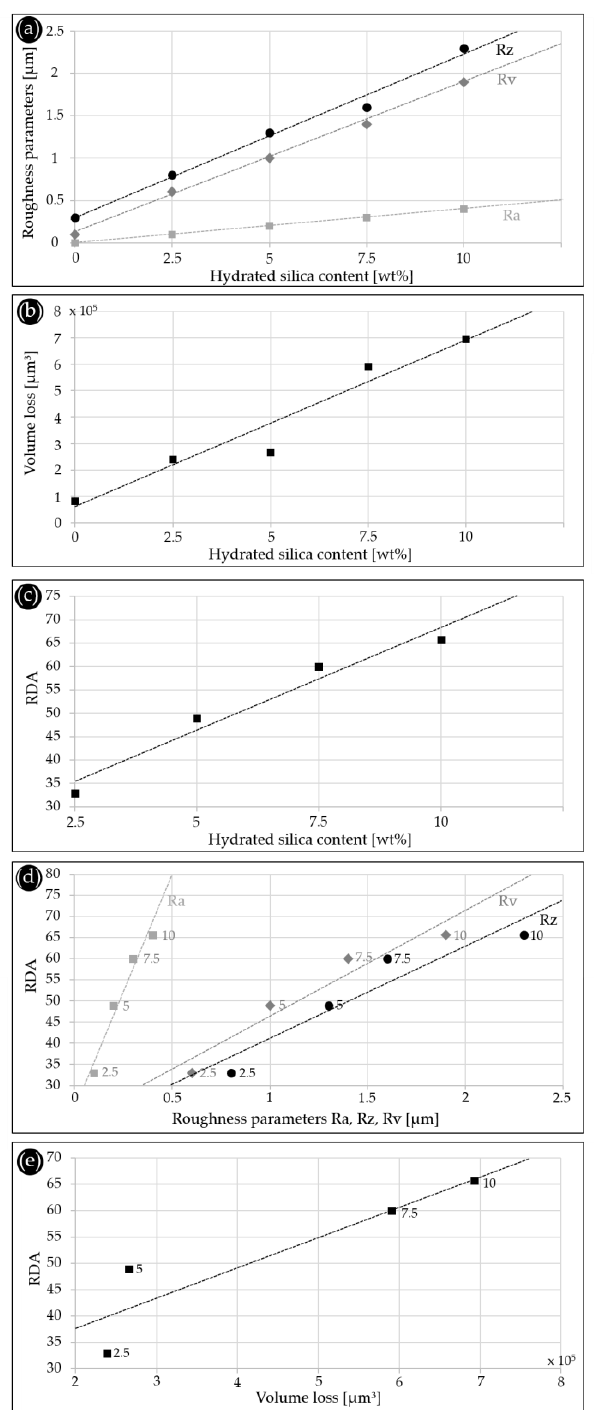
Figure 4. Abrasivity of model toothpaste formulations. ( a ) Mean values (n = 3) of the roughness parameters Ra, Rz and Rv in dependence of the hydrated silica particle content. ( b ) Mean volume loss (n = 3) with increasing weight percentage of hydrated silica, including the control brushed with distilled water only. ( c ) Dependence of RDA on the hydrated silica particle content. ( d ) Correlation between the roughness parameters Ra, Rz and Rv and the RDA values. ( e ) Correlation between the volume loss values and the RDA values of the model toothpastes. The dashed lines in ( a – e ) are the corresponding regression lines, the numbers in ( d ) and ( e ) indicate the hydrated silica content in [wt%].